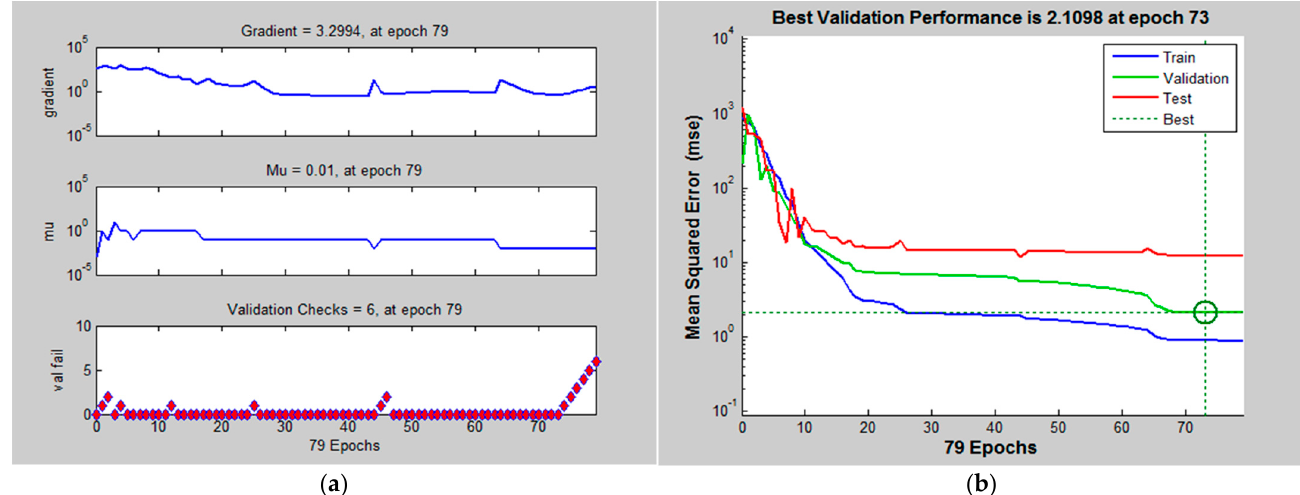
Figure 4. ( a ) Changes in parameters and ( b ) mean squared error during the model optimization processes. The results of 250 µm passing are plotted as an example.